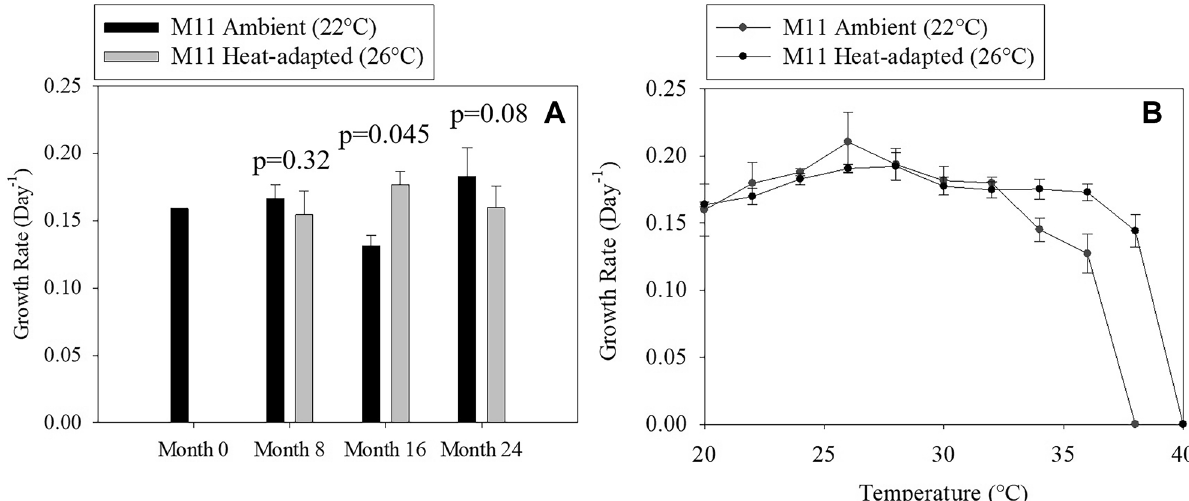
Figure 1. ( A ) Mean Growth rate and standard deviation of M. aeruginosa (strain M11) measured every 8 months for ambient (M11_22) and heat-adapted (M11_26) and ( B ) the thermal reaction norms with standard deviation showing the growth rate at 2 °C intervals between 20 and 40 °C for both ambient and heat-adapted M11.